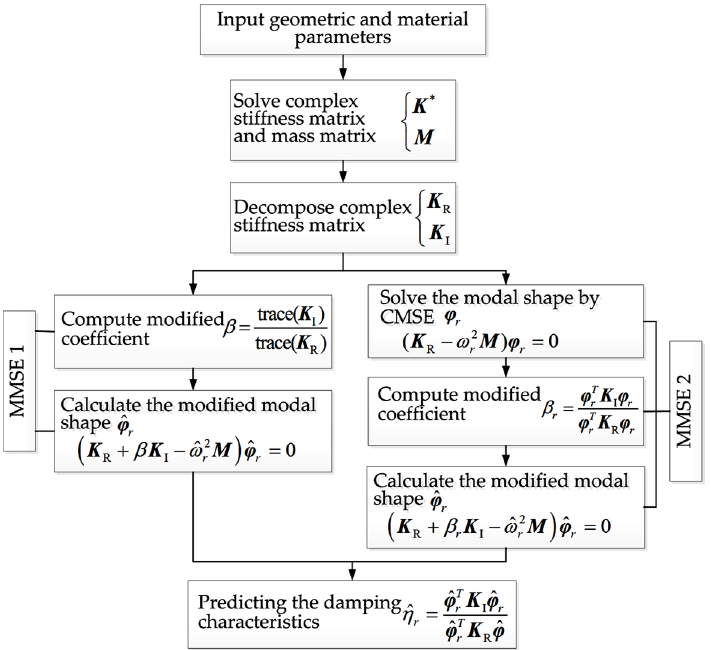
Figure 2. The calculation procedure of MMSE method.